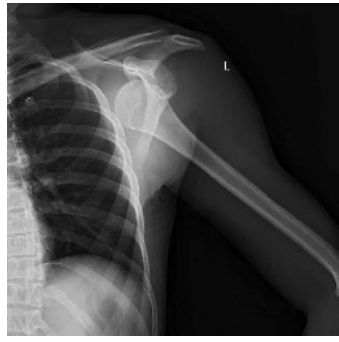
Figure 3. The anterior shoulder dislocation on radius and below the coronoid kidneys. Therapeutic blood level is about 100 to 300 ng/ mL (0.1-0.3 µg/mL) in adults (7,13).